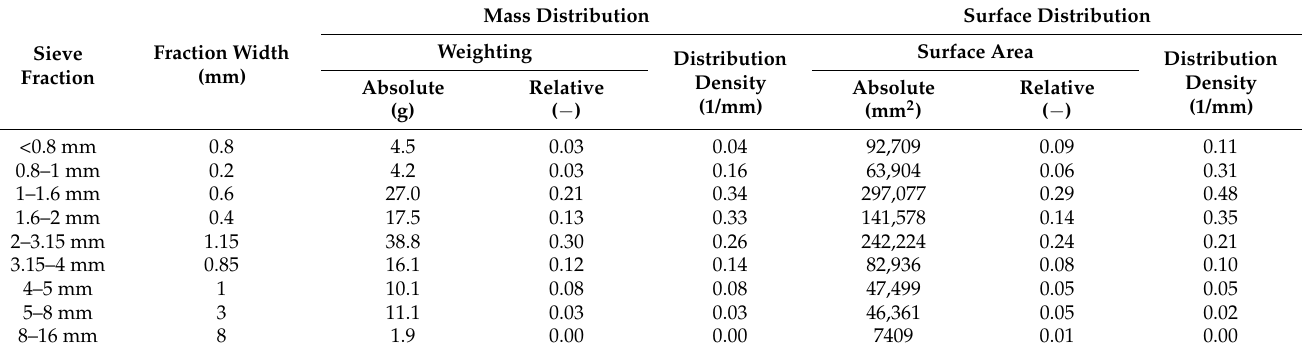
Table 6. Data used to create Figure